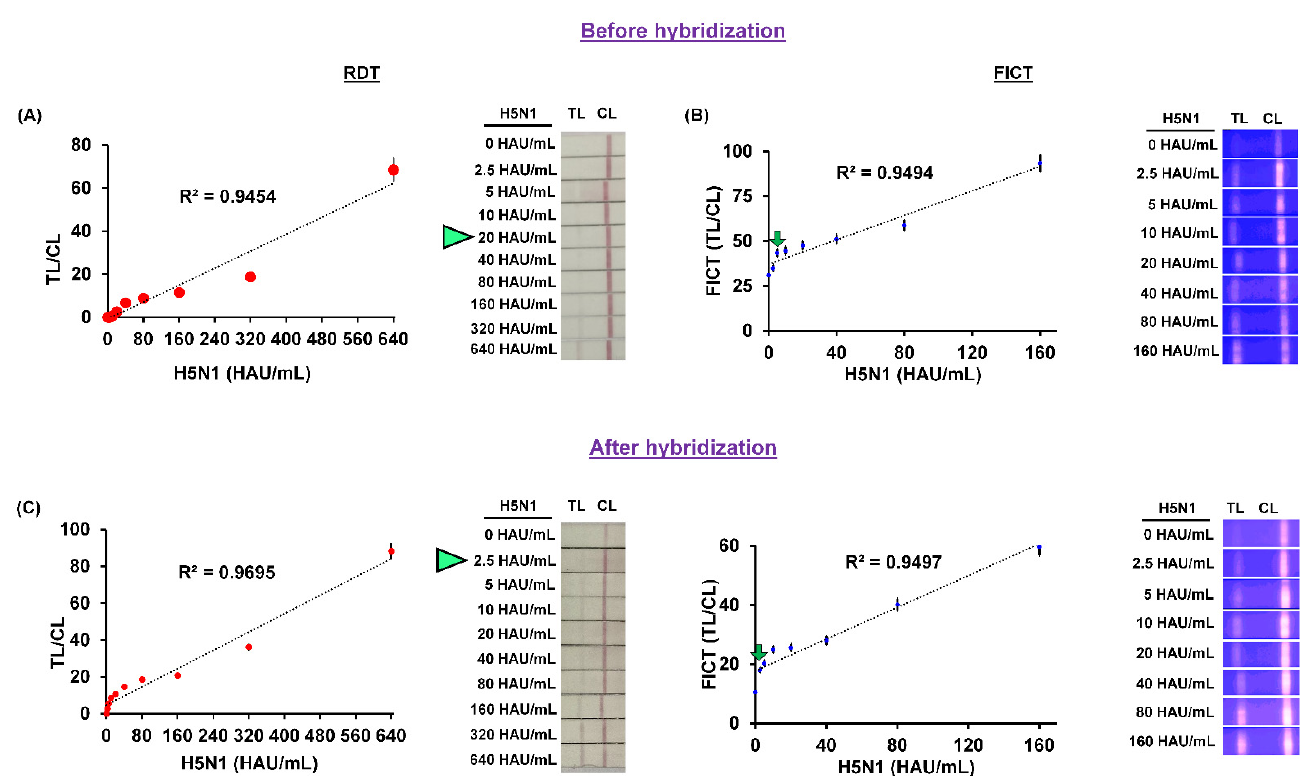
Figure 9. Comparison of nanomaterial performance in FICT and RDT. Two-fold serially diluted influenza A virus H5N1 subtypes were tested with ( A ) commercial gold nanoparticles—RDT; ( B ) Eu- ropium nanoparticles (Eu NP)-FICT; and ( C ) Cys Au-Eu nanocomposites (Cys Au-Eu NPs), both RDT and FICT. The measured FICT values were plotted on a graph and fluorescence images of Eu NP- and Cys Au-Eu NPs are shown in the left panel. The linear range for FICT using the fluorescent material conjugates was determined and the data ( n = 3) are shown as mean ± SD.